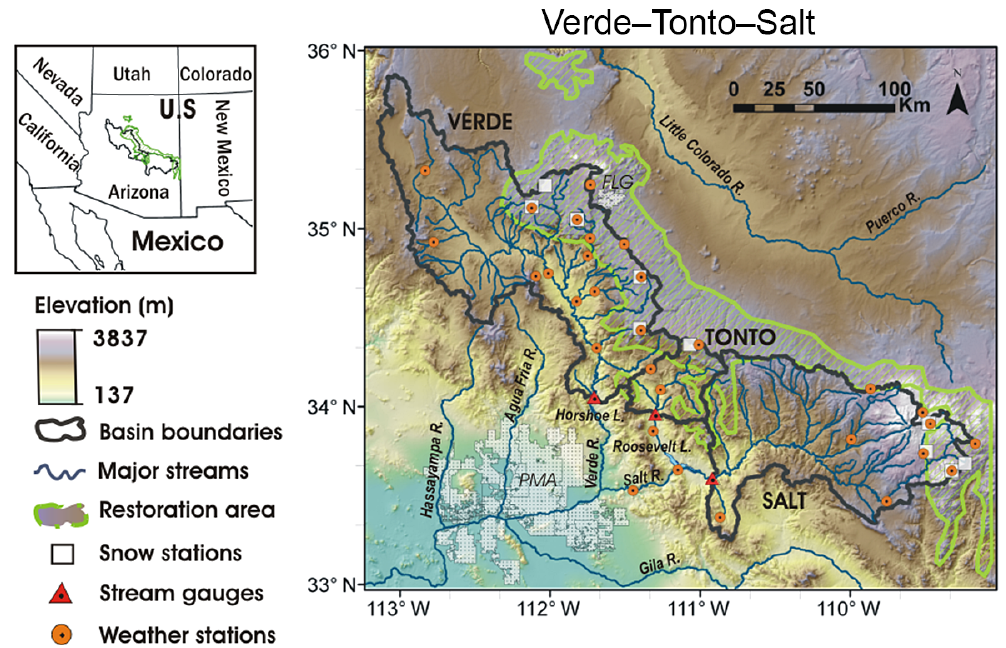
Figure 2. Map detailing the projected 4FRI restoration area and the Verde–Tonto–Salt (VTS) watershed divides. Detailed river networks, major cities and lakes, and the three basin outlets that define the VTS system are shown on a 30m USGS digital elevation